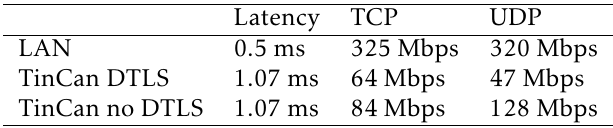
Table 2. VPN Network